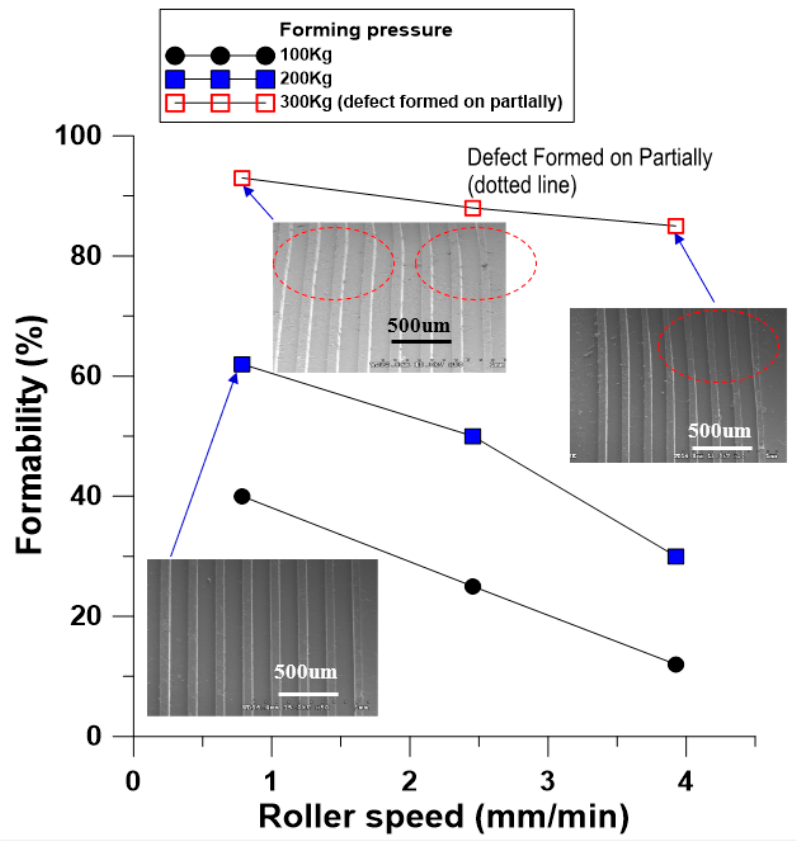
Figure 9. Effect of formability by unequal forming pressure and roller speed of belt-type PDMS microstructure soft mold.